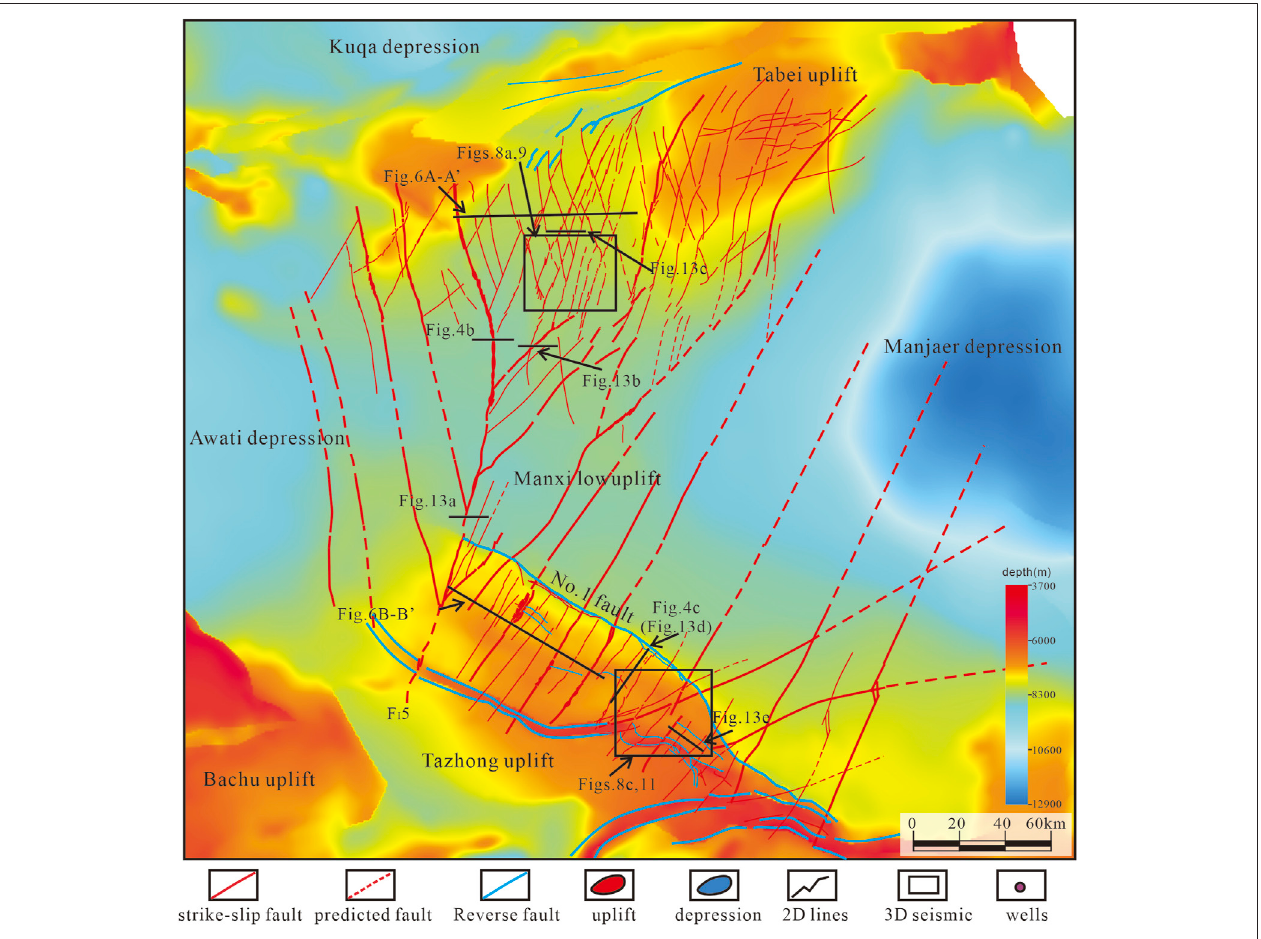
FIGURE 5 | Diagram of a strike-slip fault system of the Ordovician carbonate rocks (based on the seismic re fl ecting surface of the Ordovician Yijianfang Formation, To3).